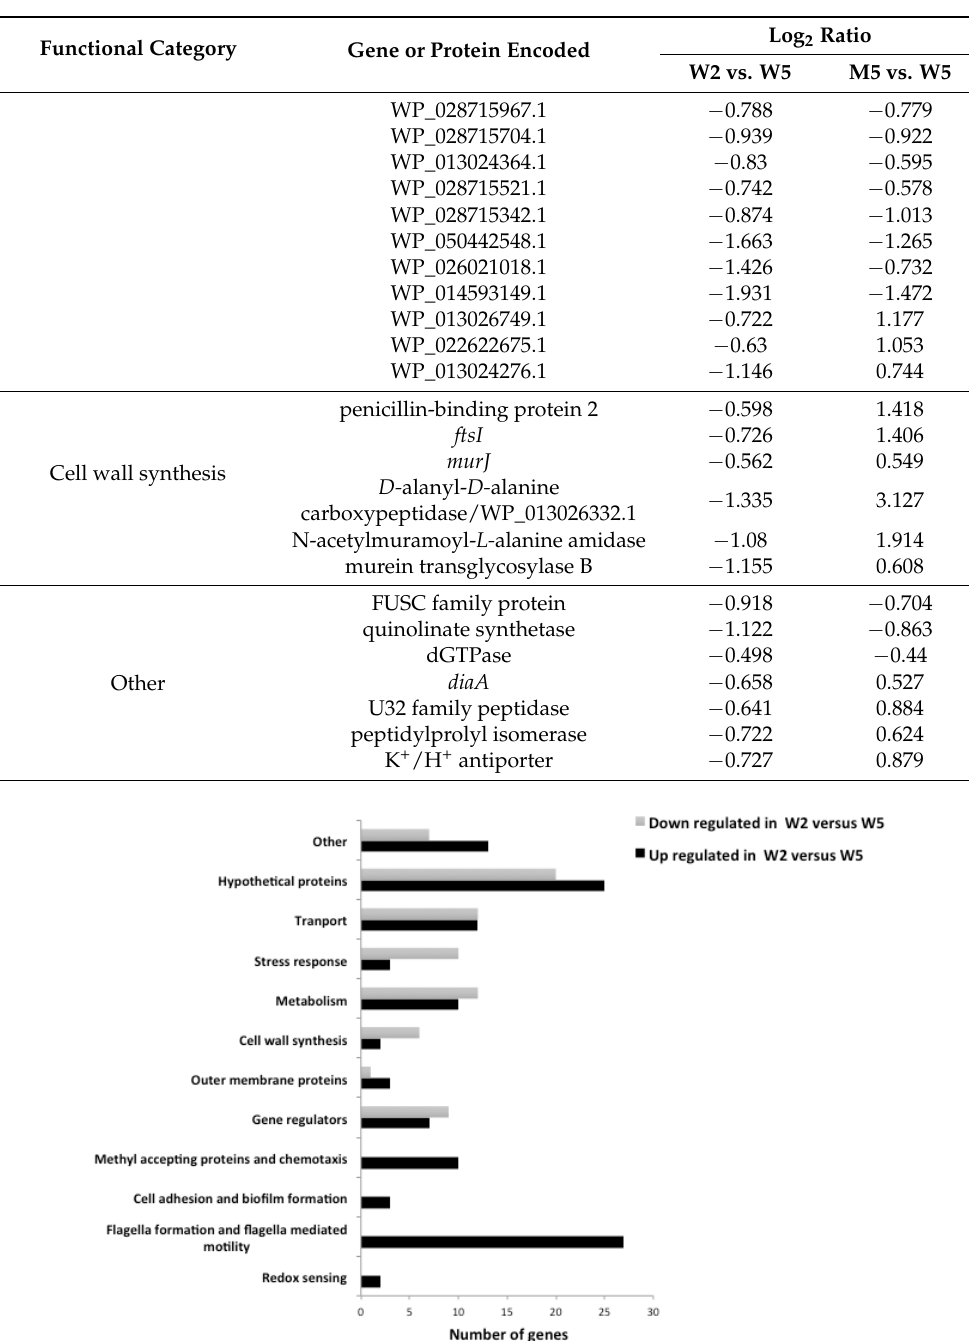
Figure 4. Functional categories of genes in the EanI/R QS regulon. The figure represents those genes in the EanI/R regulon that were differentially expressed in the wild type strain, LMG 2665 T between the two sampling points before QS and during QS. The 194 genes were grouped into different functional categories. The up regulated groups included those for flagella formation and flagella mediated motility, methyl accepting proteins and chemotaxis, redox sensing and cell adhesion. The groups with genes that were either up or down regulated included hypothetical proteins, transport, stress response, metabolism, cell wall synthesis, outer membrane proteins and